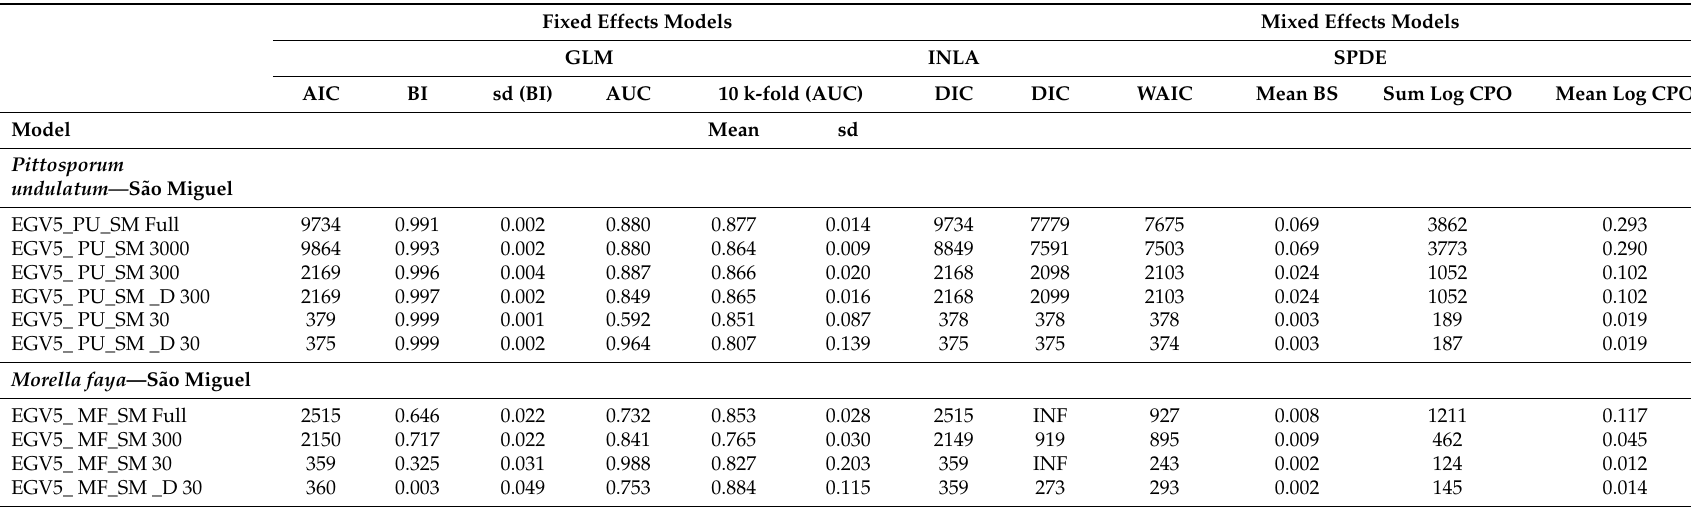
Table 6. Results of sampling reduction for fixed and mixed effects models regarding EGV set 5 for P. undulatum and M. faya in S ã o Miguel Island. BI: Boyce Index; sd: standard deviation; BS: Brier Score; PU: P. undulatum ; MF: M. faya ; SM: S ã o Miguel. Variables with non-significant values were excluded from the model (code: D) (Supplementary